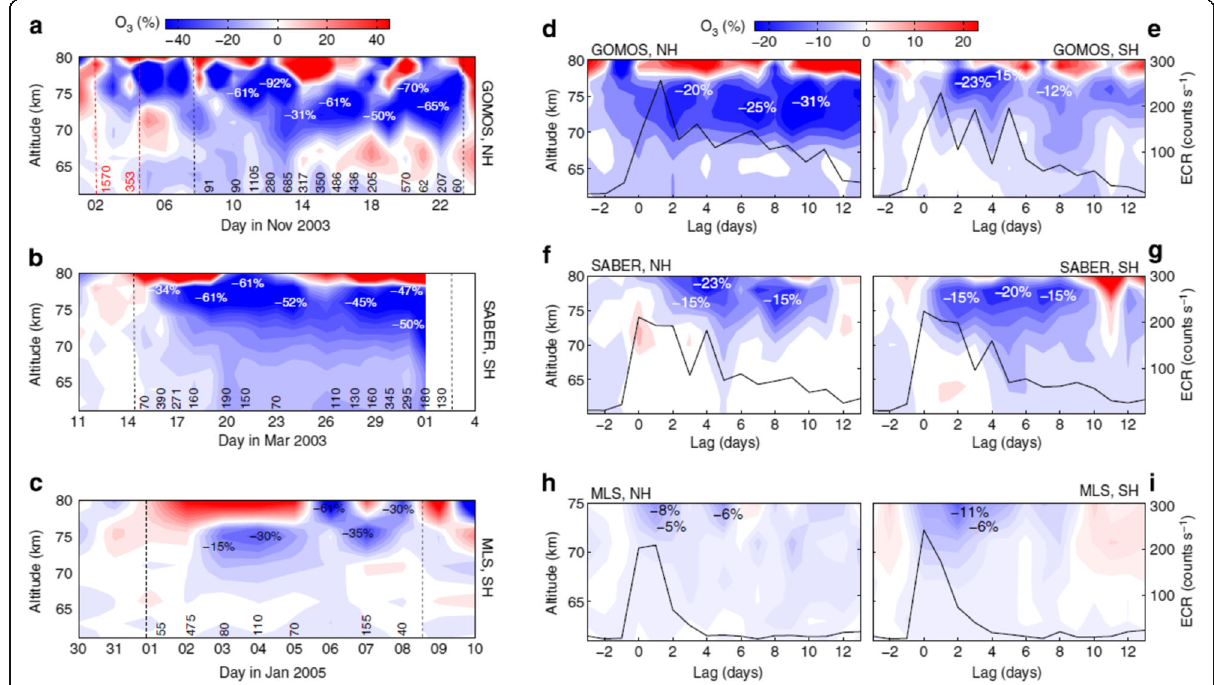
Fig. 14 Magnitude of the short-term EEP effects on mesospheric ozone. a – c O 3 anomalies (%) for selected EEP events in the Northern hemisphere and in the Southern hemisphere derived from GOMOS ( a ), SABER ( b ), and MLS ( c ) observations. Black dashed lines: EEP event start end end; red dashed lines: SPE event start end; black numbers: daily mean electron count rates (ECRs); red numbers: 410 MeV pfu. d – i Superposed epoch analysis for EEP events with daily ECR 4150 (counts s1) showing ozone anomalies (%) and ECR (black lines) in the Northern hemisphere ( d , f , h ) and in the Southern hemisphere ( e , g , i ). White numbers: O 3 loss at different altitudes (taken from Andersson et al.